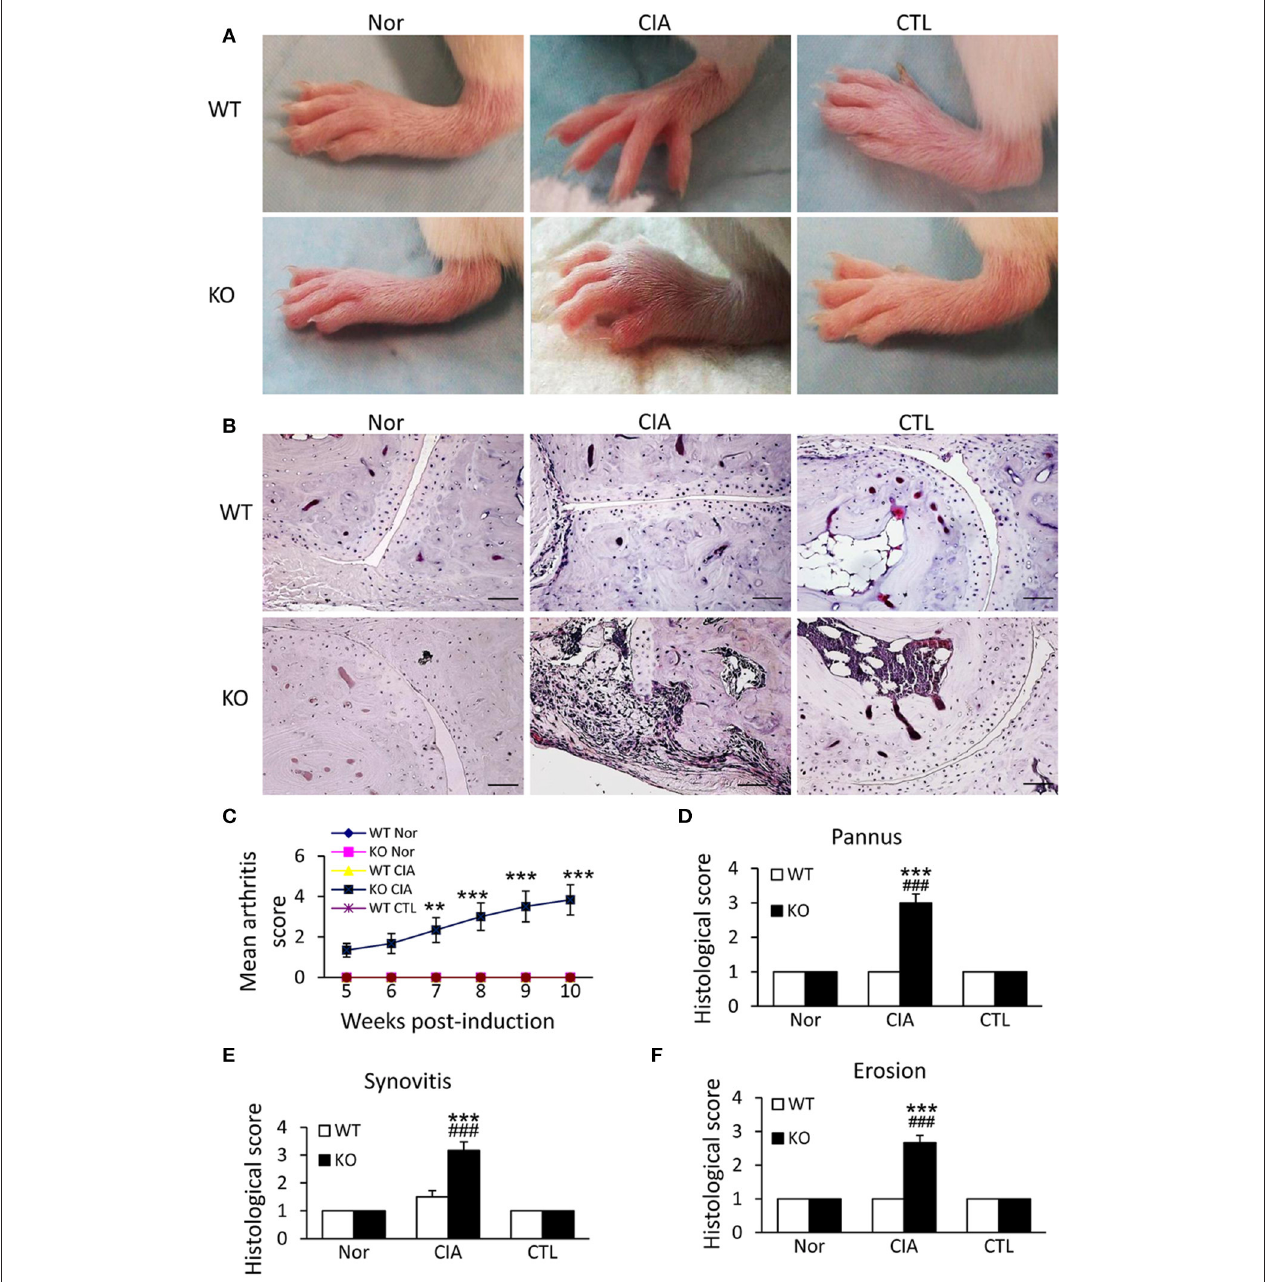
FIGURE 3 | Smad7 deficiency promotes the susceptibility to CIA in CD-1 mice. (A) Severe swelling of paws is developed in Smad7-KO but not in Smad7-WT CIA mice at week 10 after disease induction. ( B) Severe pathological changes with massive inflammatory responses are developed in Smad7-KO but not in Smad7-WT CIA mice at week 10 after disease induction. Scale bar, 50 µ m. ( C–F) Pathological mean scores of arthritis (C) pannus (D) synovitis (E) and erosion (F) at week 10 of paws tissues. Data are expressed as mean ± S.E. for group of 8 mice. ** p < 0.01, *** p < 0.001 vs. control (CTL); ### p < 0.001 vs. CIA-Smad7-WT mice.